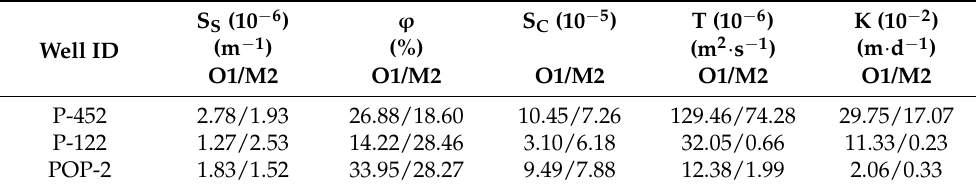
Table 4. Summary of estimations of hydrogeological parameters for the rock materials that constitute the Guadalupe Valley